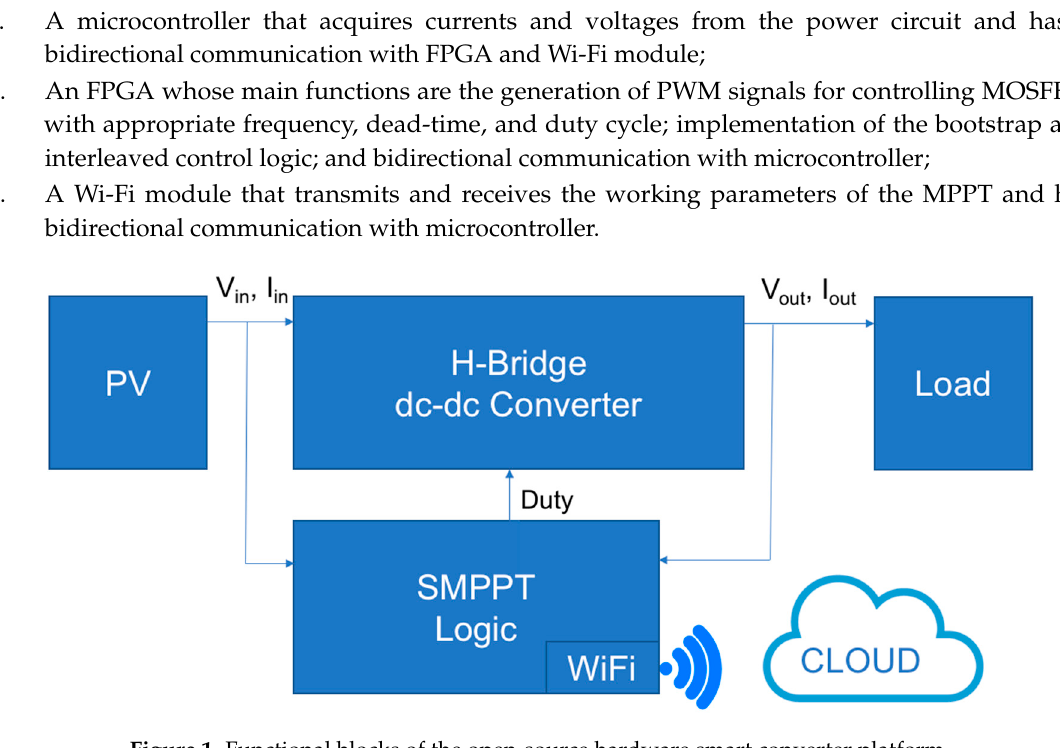
Figure 1. Functional blocks of the open-source hardware smart converter platform.